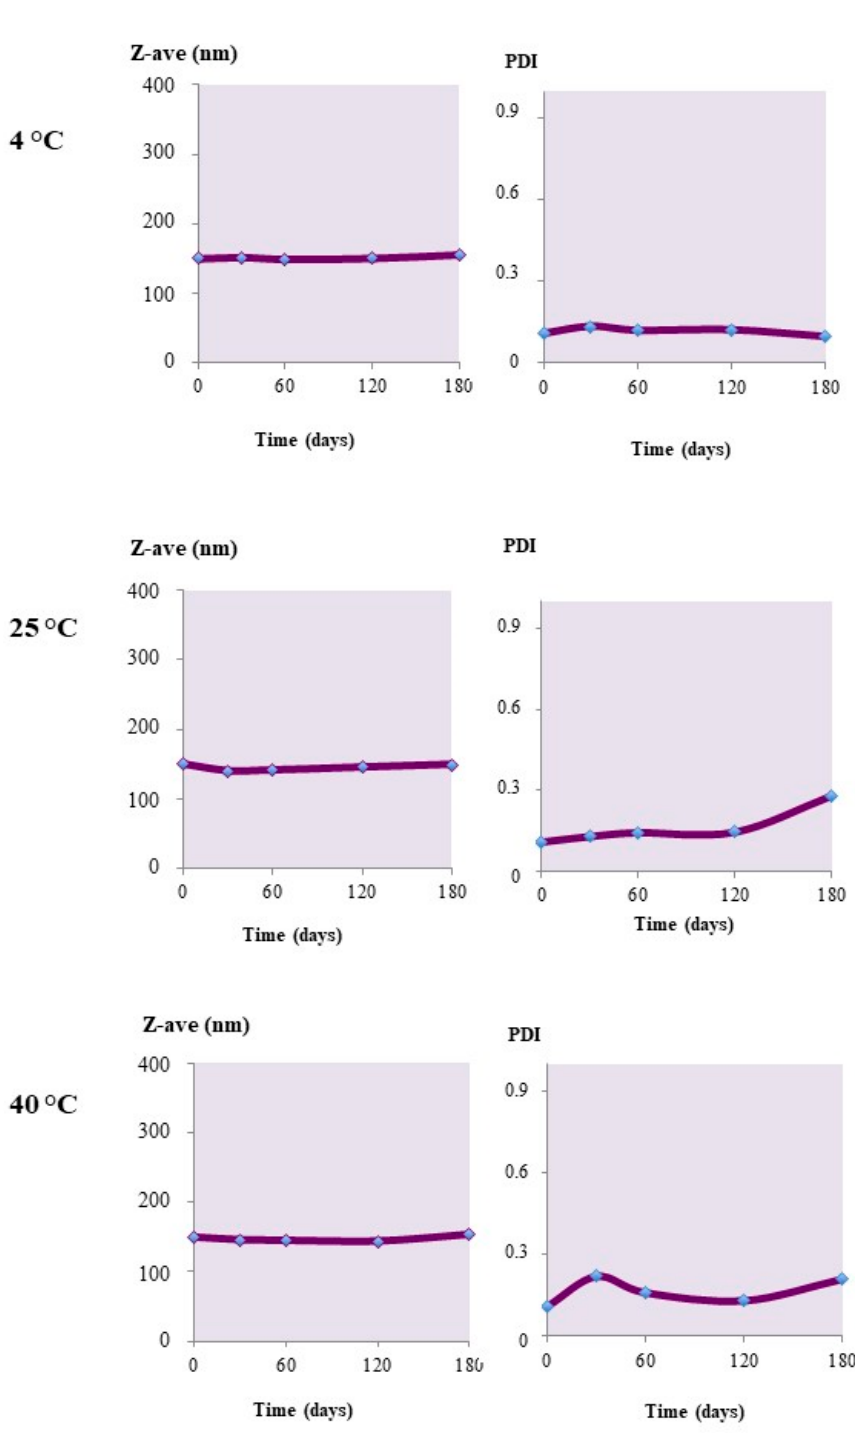
Figure 5. Z-Ave and PdI changes of calcein-loaded Uns-PHA nanoparticles stored at different temperatures.